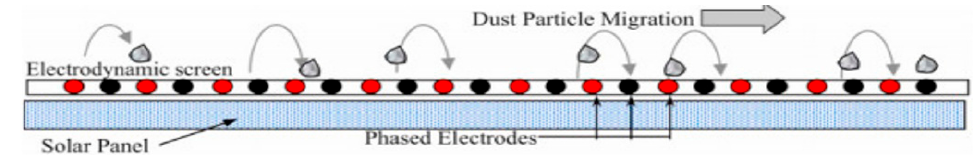
Figure 4. The working principle of electrodynamic screen [17].